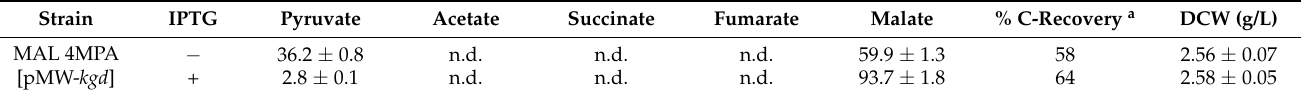
Table 4. Molar yields of metabolites produced by the strain MAL 4MPA [pMW- kgd ] during function- ing in biocatalyst